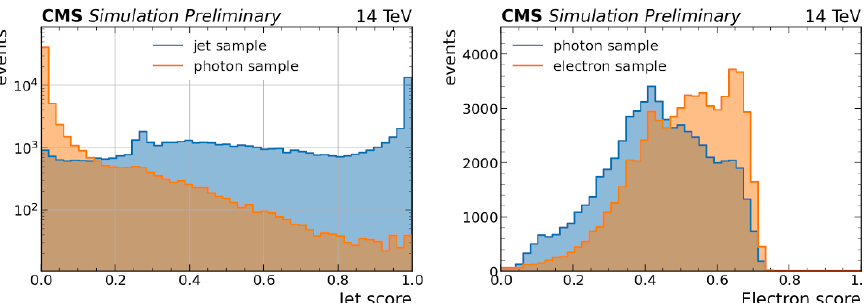
Figure 3. Model score distributions for particle identification. The jet score ( left ) represents the likelihood of the SuperCluster to originate from a photon. Clear discrimination between jet and photon samples is visible for this case. The electron score ( right ) represents the likelihood of the SuperCluster to originate from an electron. It demonstrates that despite the absence of the tracker information, some discrimination can be achieved between photon and electron